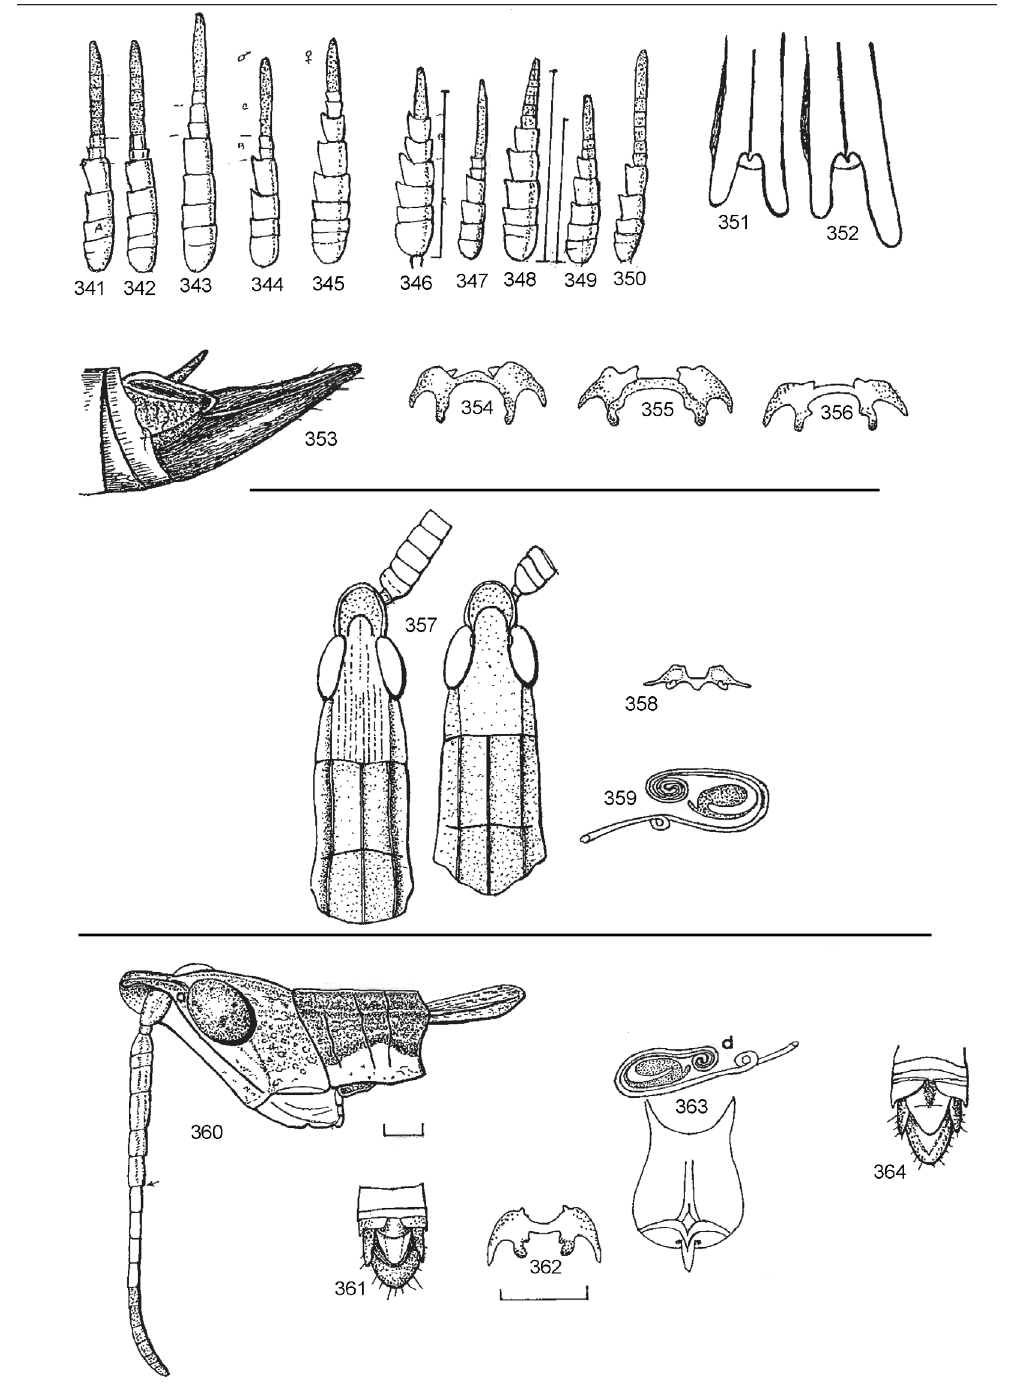
Figs 341–364. Tribe Pargaini: morphology. Figs 341–356. Parga spp.: 341–350. Antennae: 341–343 . P. musanae: 341 . Male (Uganda, Soroti); 342. Male (Tanzania, Mkomasi); 343. Female, same; 344, 345. P. taeniata : 344. Male (Tanzania, Old Shinyanga); 345. Female (Tanzania, Kisulu); 346–349. P. xanthoptera : 346. Female, (Tanzania, 8ml. S. of Chala mission); 347. Male (Tanzania, Ufipa); 348 . Female, (Uganda, Tororo); 349. Female, (Tanzania, S. of Chala mission); (line alongside 348 and 349 indicates length of head and pronotum); 350. P. cyanoptera, male. Figs 351, 352. Posterior femoral knee lobes from dorsal view (left leg): 351. P. xanthoptera ; 352. P. musanae ; 353. P. xanthoptera , apex of abdomen. Figs 354–356. Male epiphalli: 354. P. xanthoptera ; 355. P. musanae ; 356. P. taeniata. Figs 357–359. Machaeridia bilineata : 357. Male head and pronotum, dorsal view left, compared with Machaeridia conspersa right; 358. Epiphallus (from Hollis 1966); 359. Female spermathecal duct. Figs 360–364. Phryganomelus spp . Ph . phalangidus: 360. Head, prono- tum, antennae and tegmen in profile; 361. Abdominal apex from above; 362. Epiphallus. Ph. romi : 363. Female spermatheca and dorsal aspect of subgenital plate. Ph. auriventer: 364. Male abdominal apex from above. All scale lines represent 1 mm: Scale line under Fig. 360 applies also to Figs 341–353, 357, 359–361, 362, 364; that under Fig. 362 also applies to Figs 354–356,